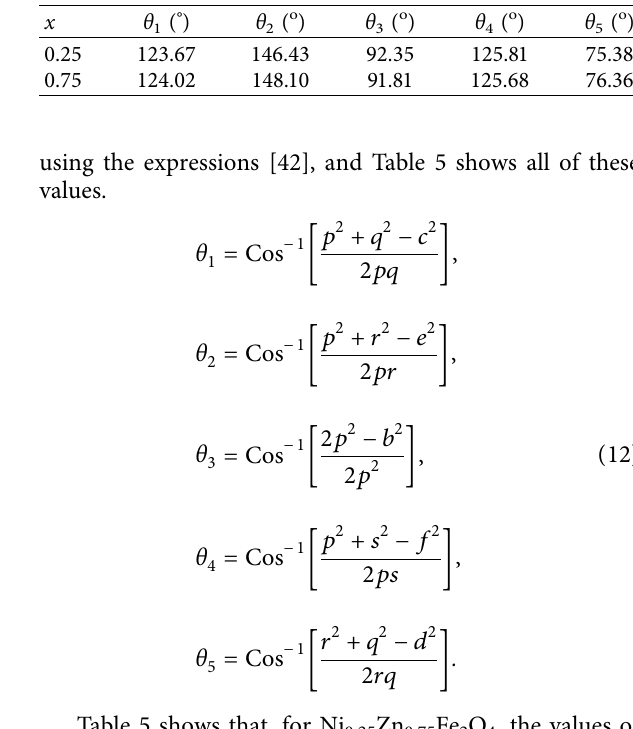
1-x Zn x Fe 2 O 4